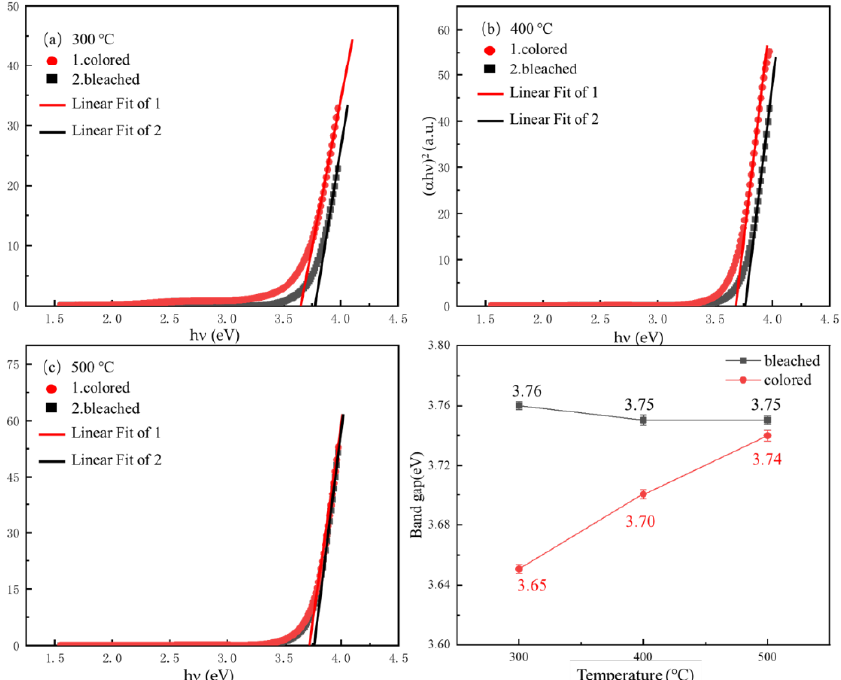
Figure 5. Optical band gap energy of NiO films in a colored state and bleached state. ( a ) 300 ◦ C; ( b ) 400 ◦ C; ( c ) 500 ◦ C; and ( d ) a comparison of optical band gap energy of NiO films annealed at different temperatures and electrochromic states (colored and bleached).